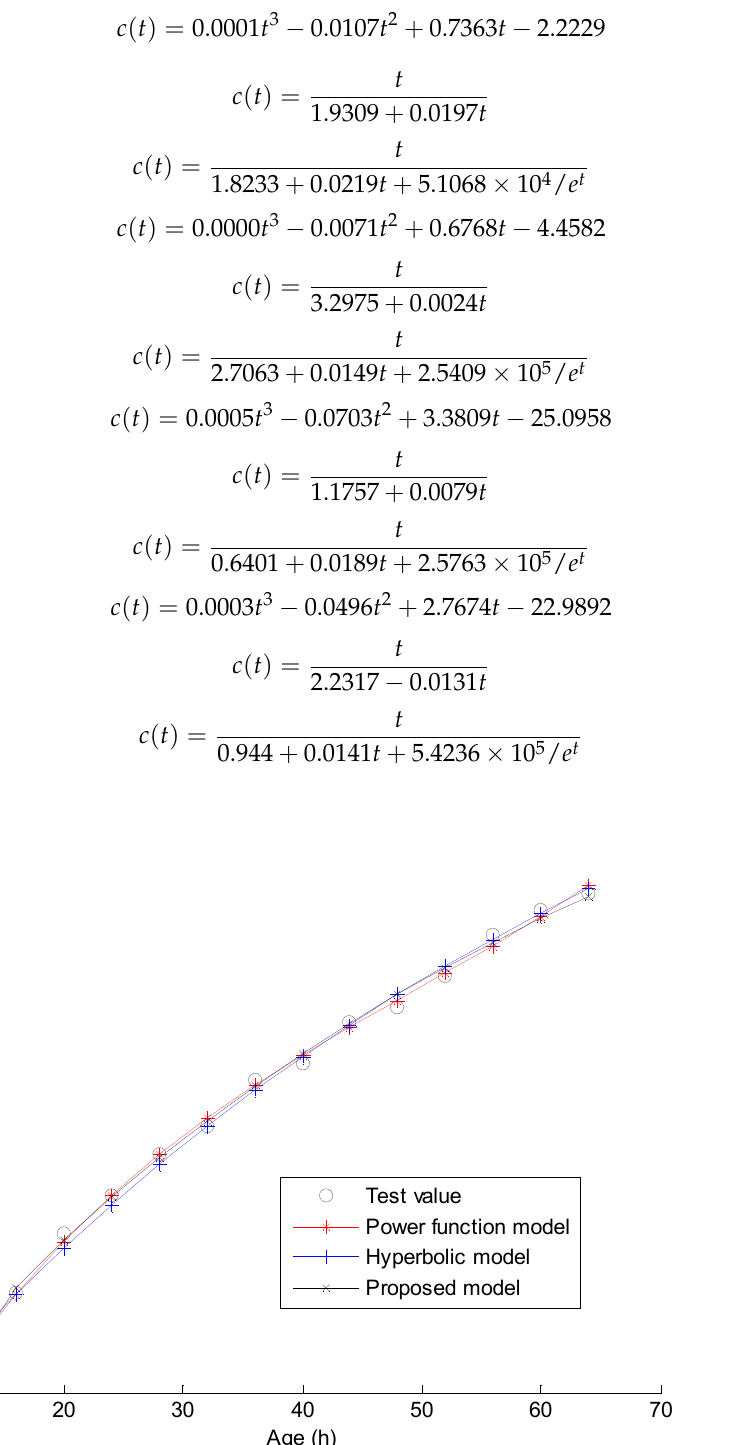
Figure 2. Curve fitting results using the three models for C30 under standard curing.